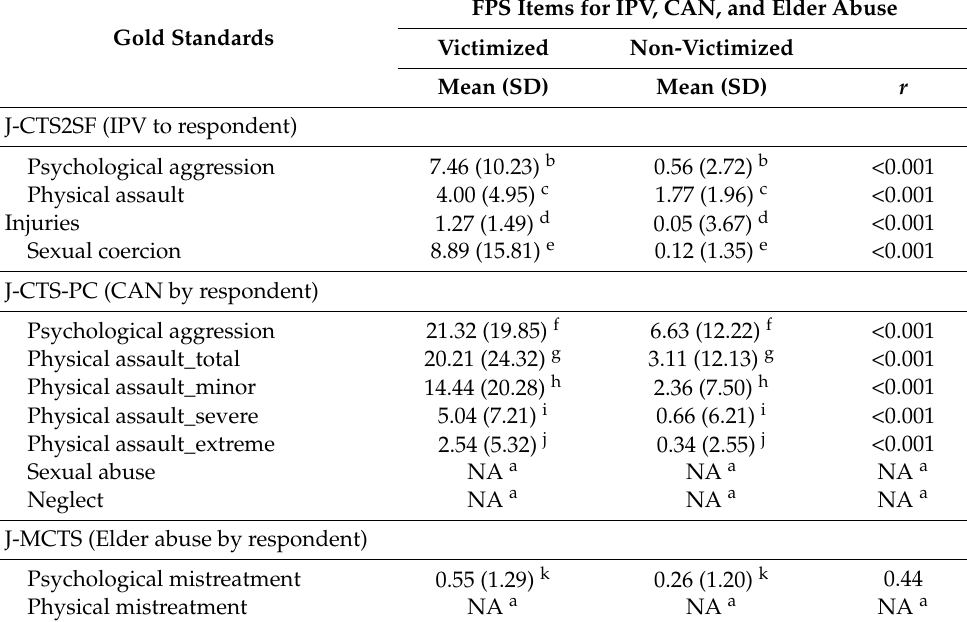
Table 4. Criterion related validity of The Japanese version of the Family Poly-victimization Screen (FPS-J; n = 483). FPS Items for IPV, CAN, and Elder Gold Standards